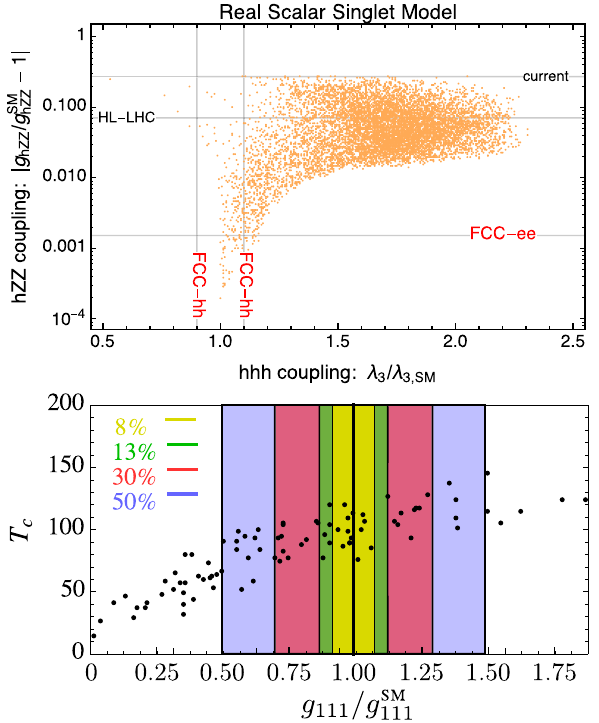
Fig. 11.4 Parameter space scan for a singlet model extension of the Standard Model. The points indicate a first order phase transition. These points lead to signals observable at future colliders. Upper panel: correlation between changes in the HZZ coupling (vertical axis) and the HHH coupling scaled to its SM value (horizontal axis). Lower panel: correlation between critical temperature T c (vertical axis) and the HHH coupling scaled to = 1. Adapted from Refs. [324,330] its SM value (horizontal axis). SM prediction for the latter is indicated as g 111 / g SM 111